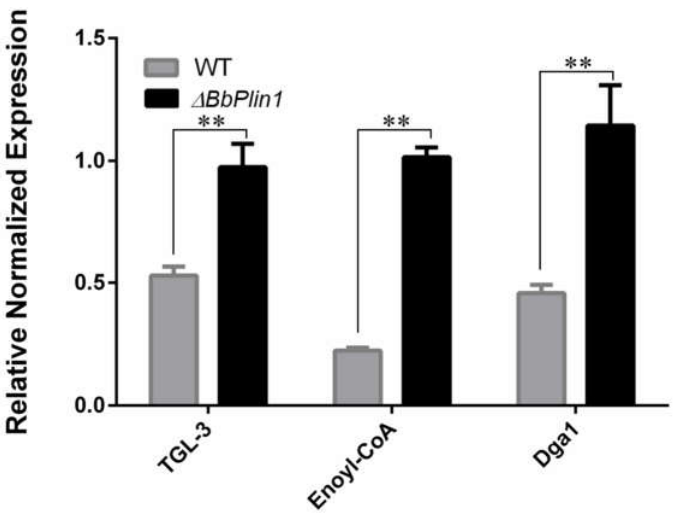
Figure 7. Effects of BbPlin1 on the expression of lipid metabolism–related genes. After culture, B. bassiana wild–type and ∆ bbPlin1 deletion strains were grown in PDB for 3 d, and the total RNA was extracted and used for RT–PCR analyses of the expression of the triacylglycerol lipase ( TGL–3 ), Enoyl–CoA hydratase (Enoyl–CoA), and diacylglycerol o–acyltransferase ( Dga1 ) genes. All experiments were performed using three technical replicates and the entire experiment was performed three times. Data are given as ±SE. Stars represent statistical difference (** p < 0.01, t test).